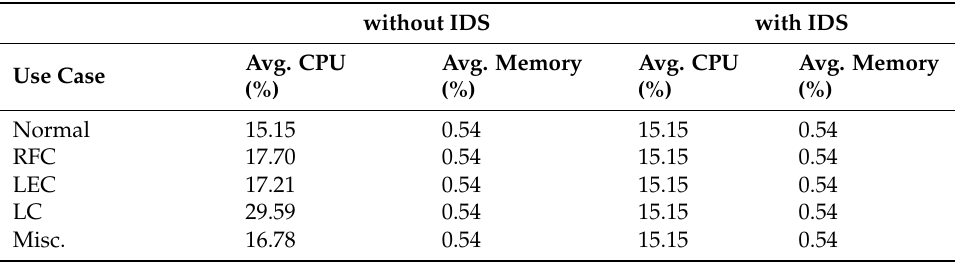
Table 2. CPU and memory utilization by MQTT broker in five experiments when performed with and without the proposed